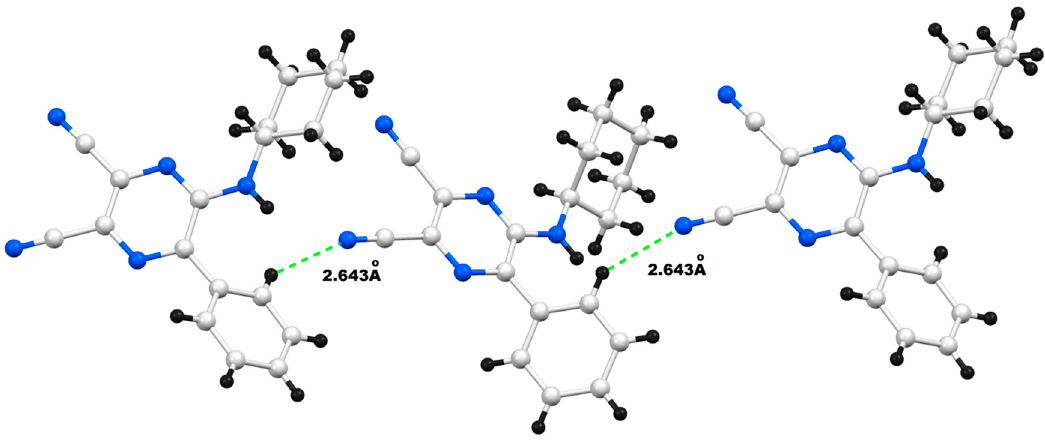
Figure 6. Intermolecular H-bonds exhibited by 13a molecules in its crystal network.